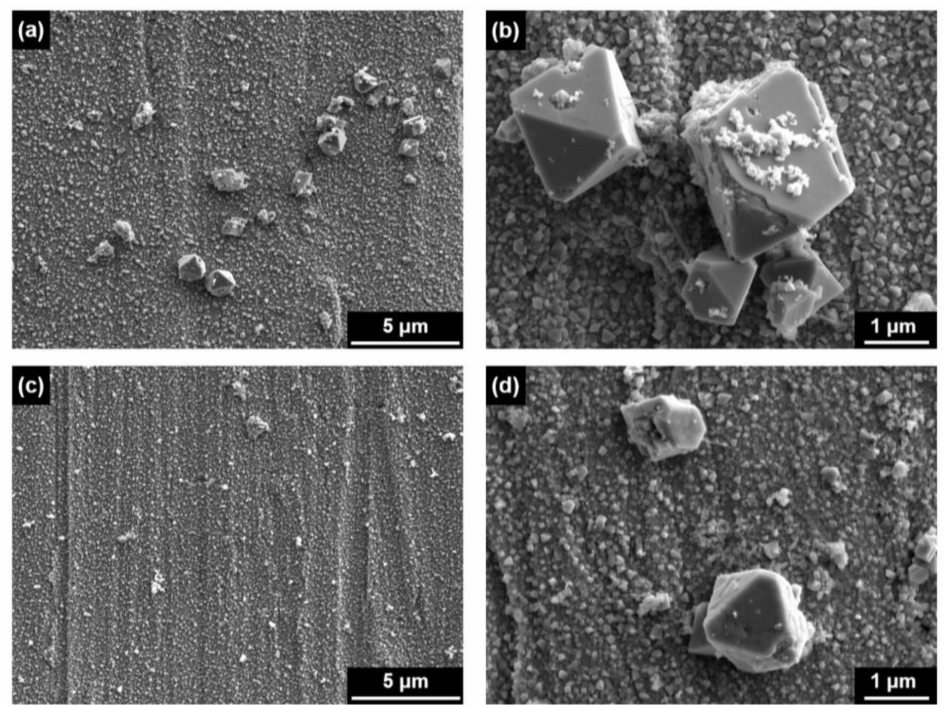
Figure 3. SEM images of oxides grown on Alloy 690 in 2 ppm Li + 1000 ppm B solution ( a , b ) without and ( c , d ) with 60 ppb Zn at 330 ◦ C: ( a , b ) Case #1 and ( c , d ) Case